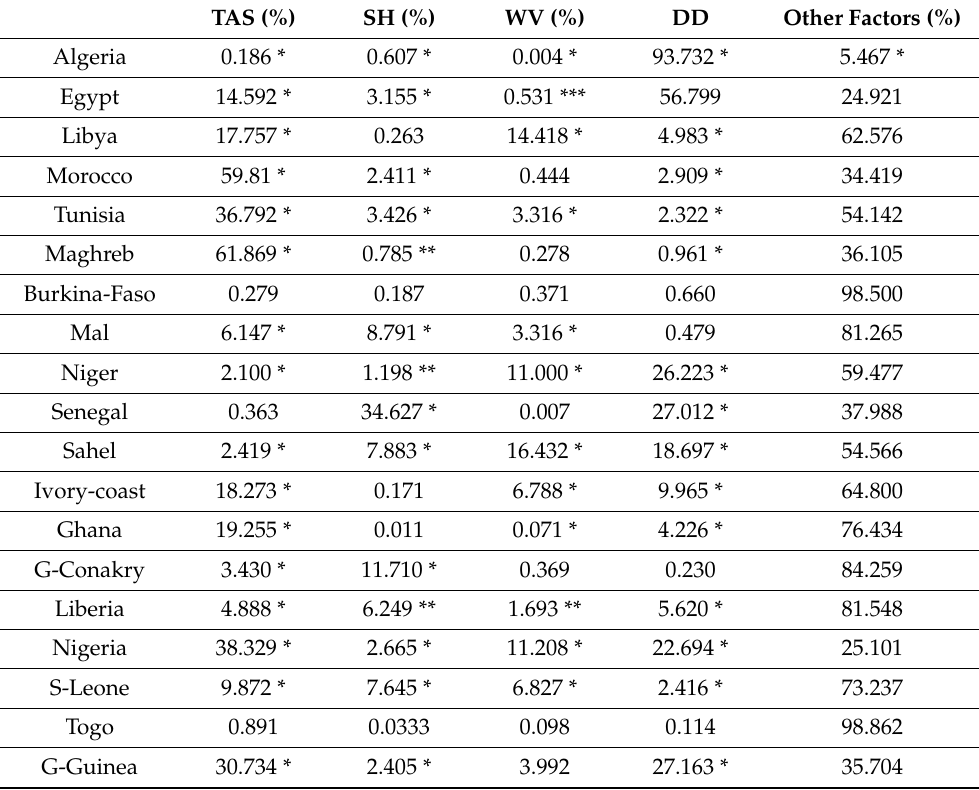
Table 1. Summary of the values of the percentage of variance explained in Figure 8. Contributions with a significant statistic at 99% are indicated by **, significant at 95% by *. TAS ( ◦ C), SH (g/kg), and WV (g/kg) represent the temperature, specific humidity, and water vapor climate variables, respectively. At the same time, “DDT” and “Other factors” refer respectively to the dynamics of the disease transmission (DDT) and the non-climatic